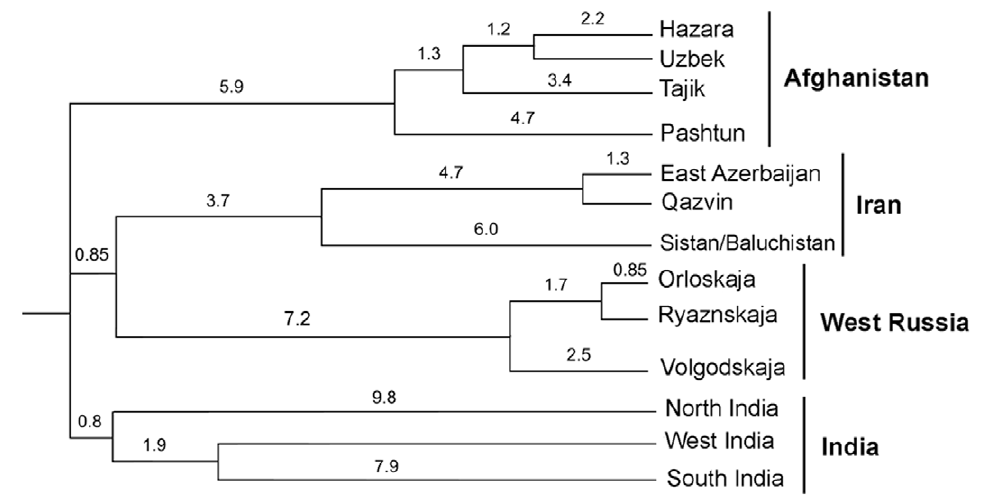
Figure 3. Composite BATWING population splitting. The composite tree is constructed from data sets described in the text, based on the results displayed in Table S6, with a pruned leading topology and averaged times. Numbers indicate branch lengths measured in thousand years.